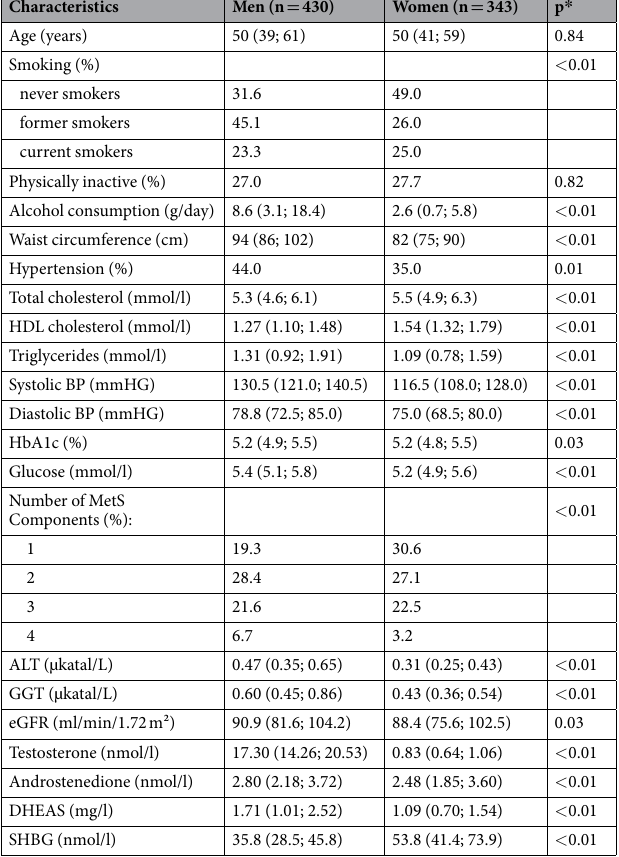
Table 1. General characteristics of the study population. HDL = high density lipoprotein; BP = blood pressure; HbA1c = glycated hemoglobin; ALT = alanine aminotransferase; GGT = γ -glutamyl transpeptidase; eGFR = estimated glomerular filtration rate; DHEAS = dehydroepiandrosterone–sulfate; SHBG = sex hormone- binding globulin; Continuous data are expressed as median (25th percentile; 75th percentile); nominal data are given as percentages. * χ 2-test (nominal data) or Mann-Whitney test (interval data) were performed; To convert the values of testosterone from nanomoles per liter to nanograms per deciliter, multiply by